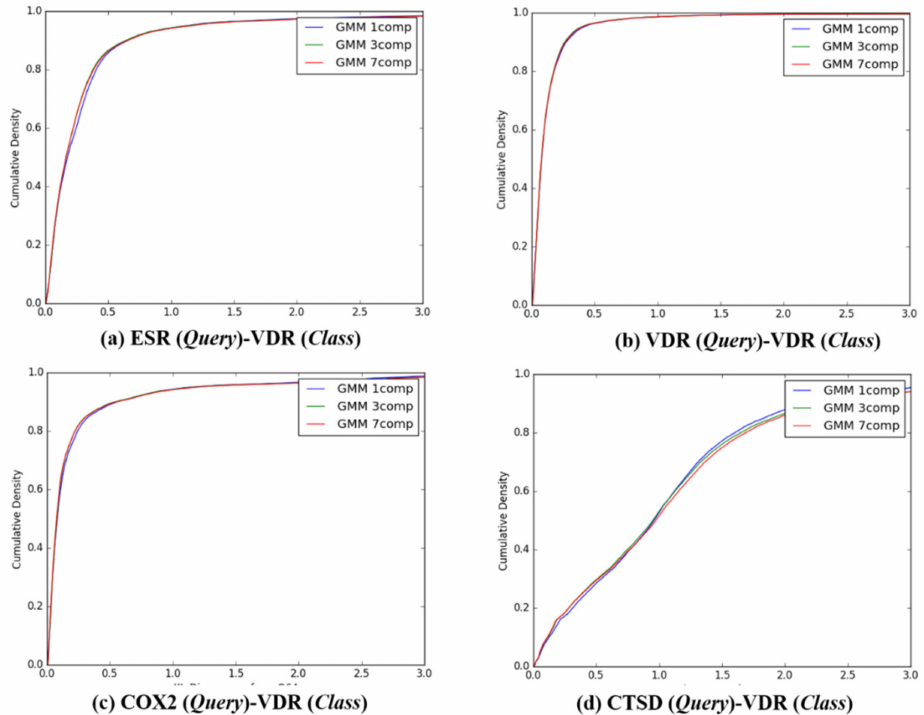
Figure 5. The cumulative densities of K–L distance between Q -distribution (Target class: VDR) and queries. X -axis: K–L divergence, Y -axis: cumulative density; Q -distribution of VDR through GMM and the distribution of queries were calculated. ( a ) ESR(Query)-VDR(Class), ( b ) VDR(Query)-VDR(Class), ( c ) COX2(Query)-VDR(Class), and ( d )